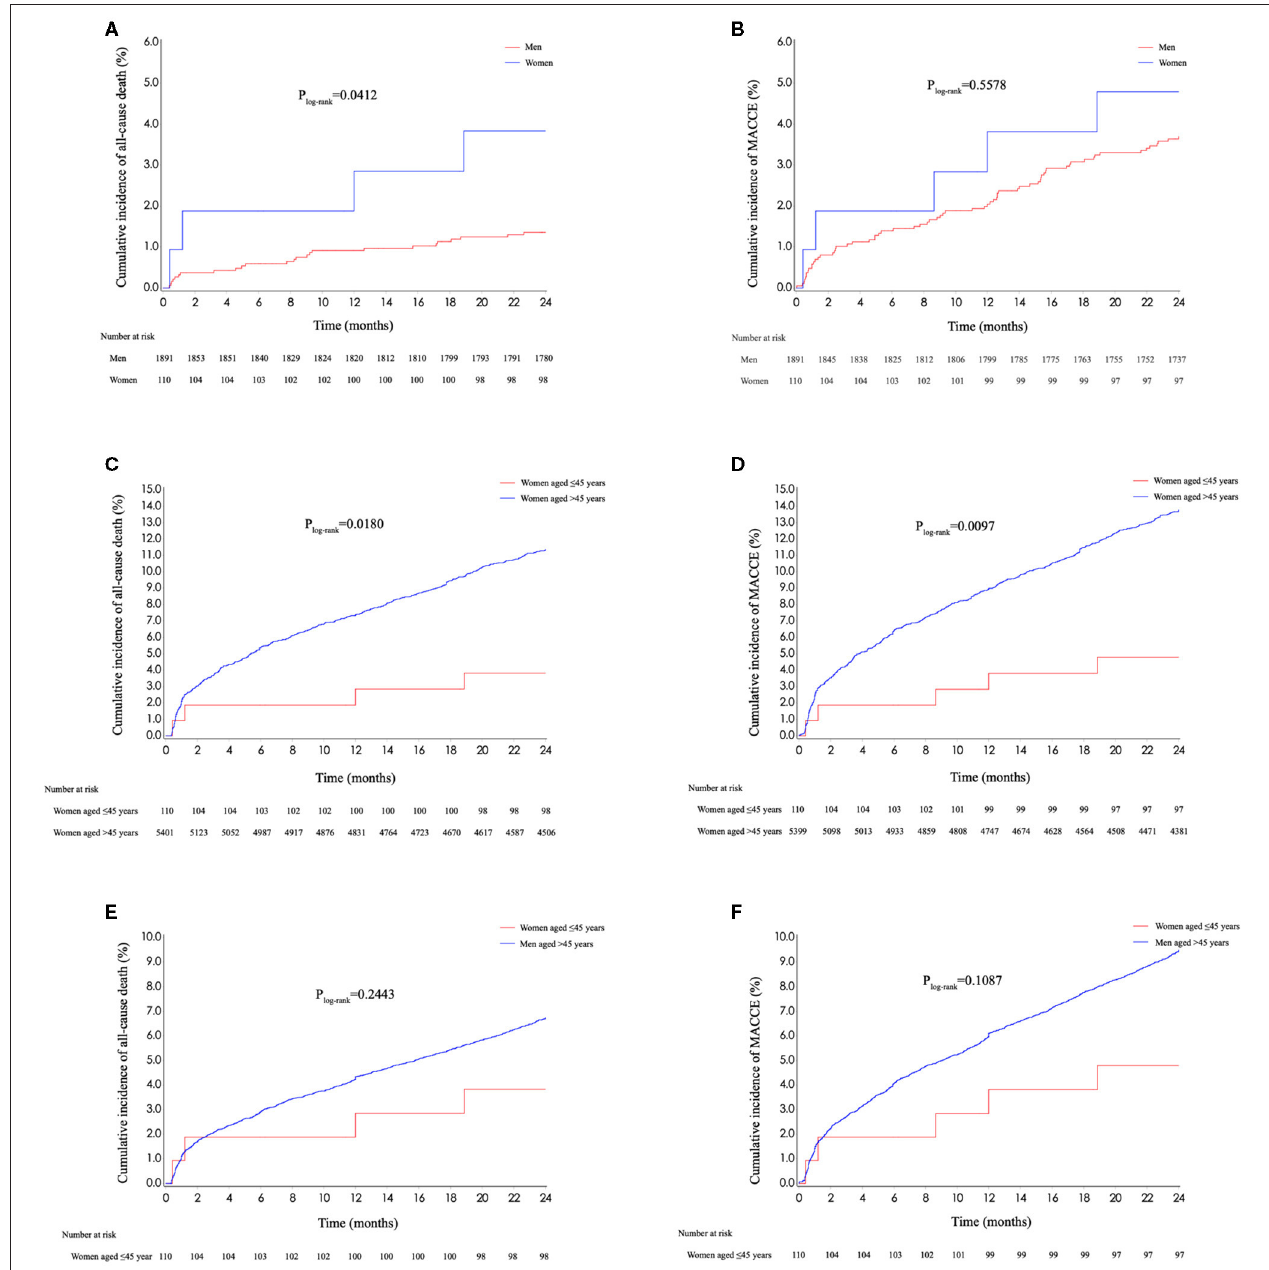
FIGURE 4 | Kaplan–Meier curves stratified by sex and age. (A) Kaplan–Meier curves for all-cause death stratified by sex in young patients. (B) Kaplan–Meier curves for MACCE stratified by sex in young patients. (C) Kaplan–Meier curves for all-cause death stratified by age in women. (D) Kaplan–Meier curves for MACCE stratified by age in women. (E) Kaplan–Meier curves for all-cause death of young women and older men. (F) Kaplan–Meier curves for all-cause death of young women and older men. MACCE, major adverse cardiac and cerebrovascular